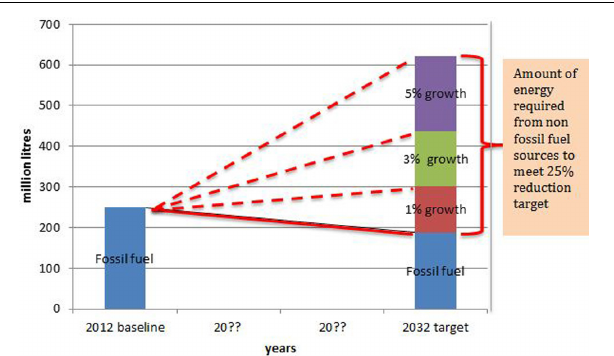
FIGURE 1 | Amount of non-fossil fuel energy required to achieve a 25% reduction for sea transport by 2033 for PICs assuming a 2012 nominal baseline of 250 million liters under 1, 3, and 5% average annual growth scenarios (source: this